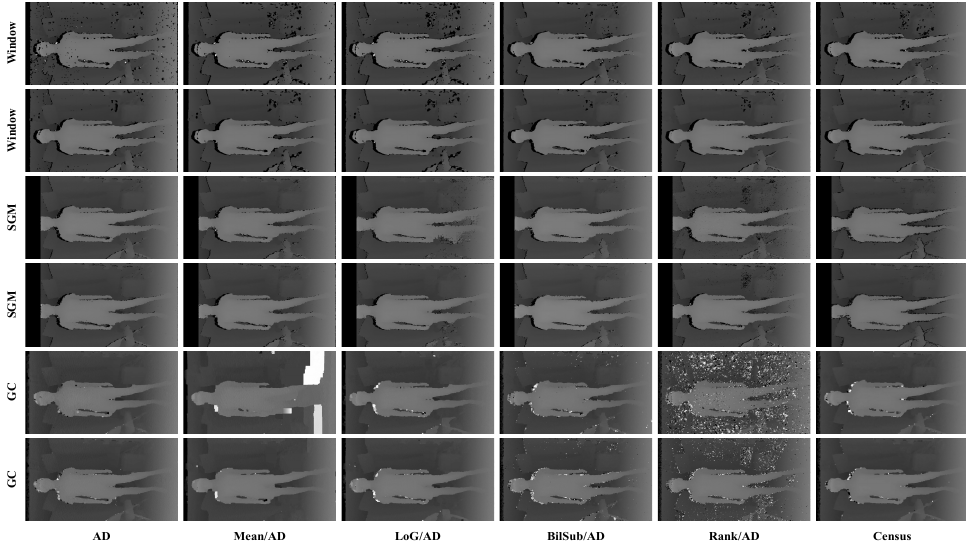
Figure 31. Estimated real disparity images of the combinations of cost and image filter using each stereo matching method, according to the parameter of the number of pattern dots . The upper line indicates the low parameter, and the lower line indicates the high parameter for each stereo matching method,